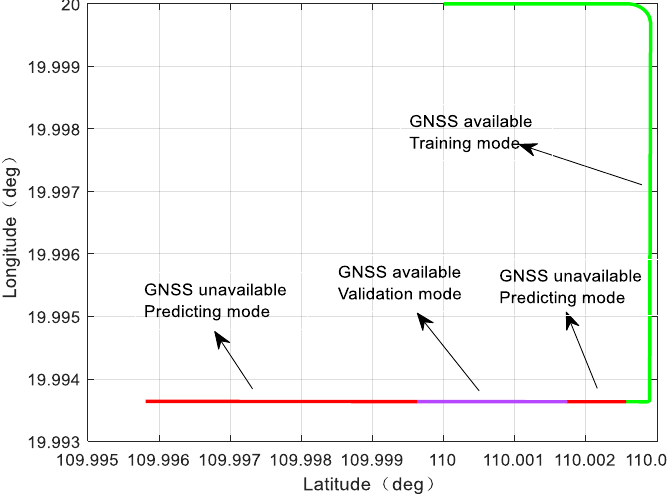
Figure 13. The trajectory of simulation and corresponding modes of virtual sensor.